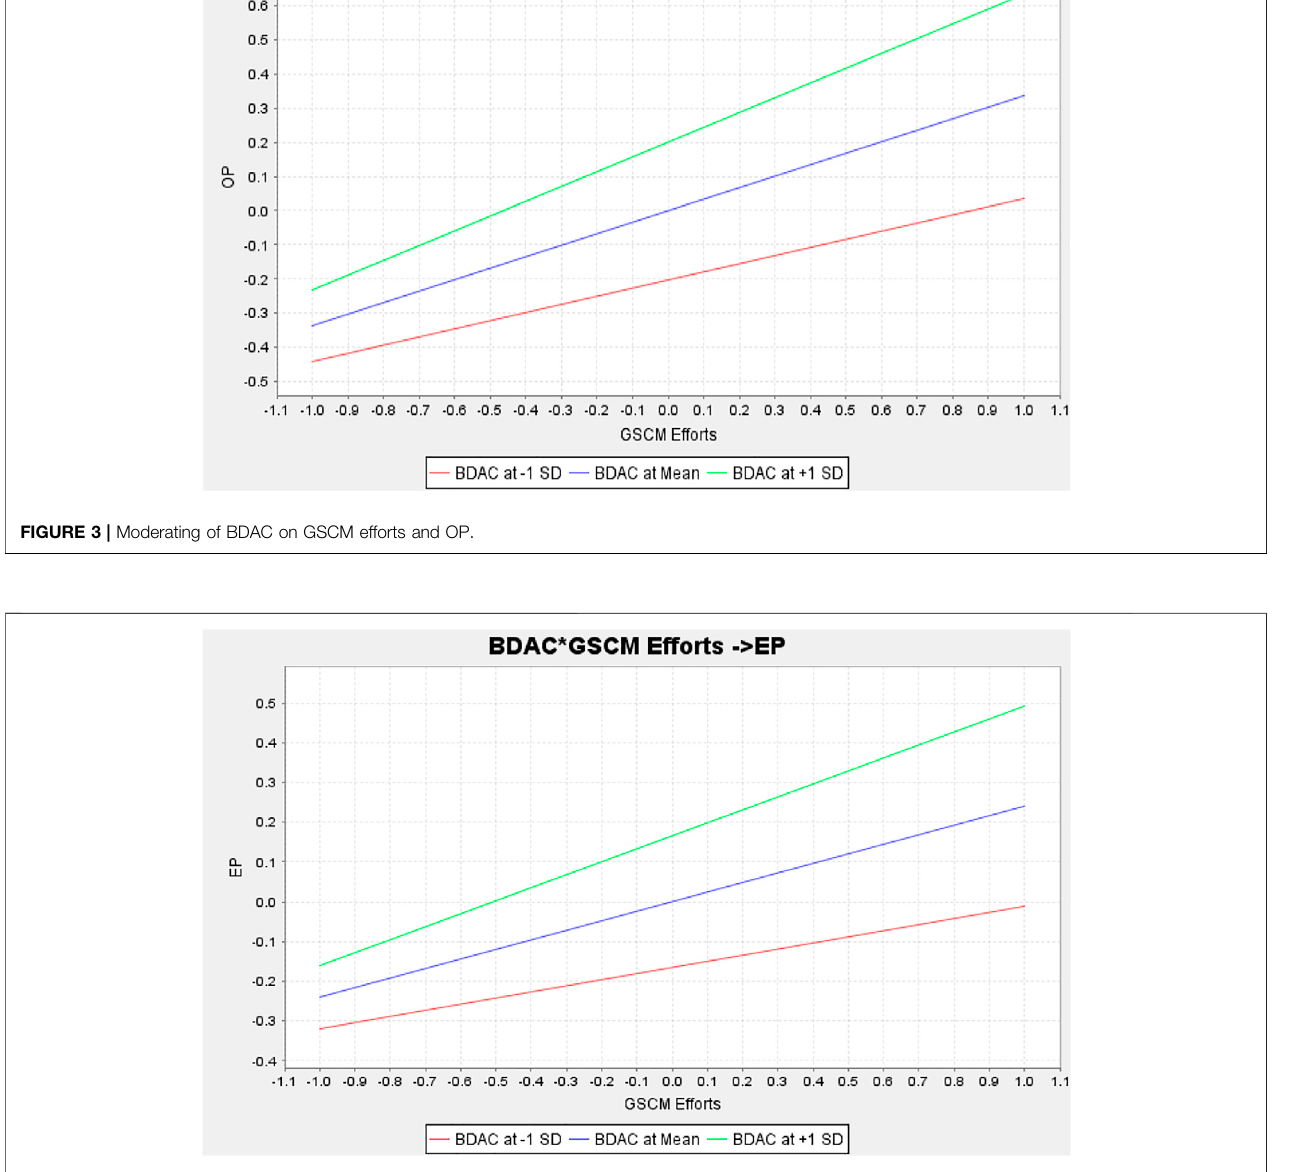
Figure 4 represents the positive moderation effect of BDAC on the impact of GSCM efforts on EP.